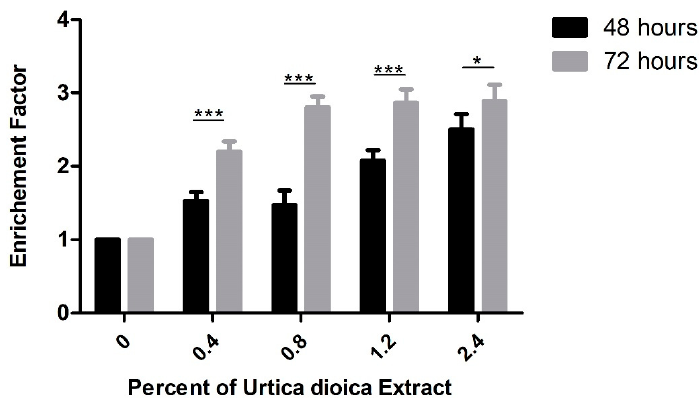
Figure 7. Cell-death ELISA showing the e ff ect of UD extract on increasing DNA fragmentation in U937 treated with di ff erent concentrations of UD extract at 0.4, 0.8, 1.2, and 2.4% after 48 and 72 h. The graph represents the means from three independent experiments +/ − SEM. * and *** indicate p < 0.05 and p < 0.0001, respectively, compared to the control group.